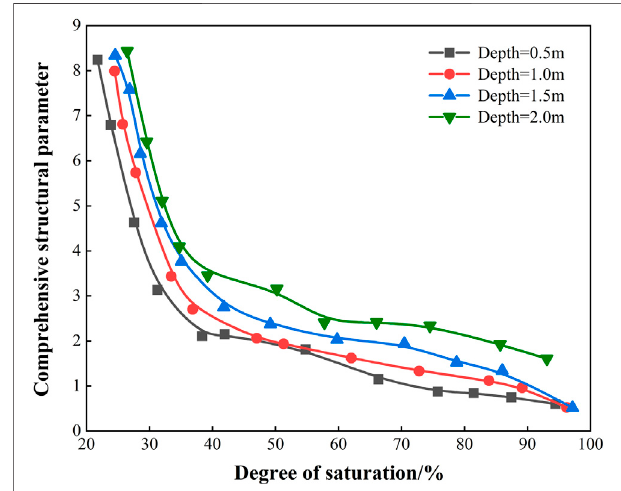
FIGURE 8 | Relationship between comprehensive structural parameter and degree of